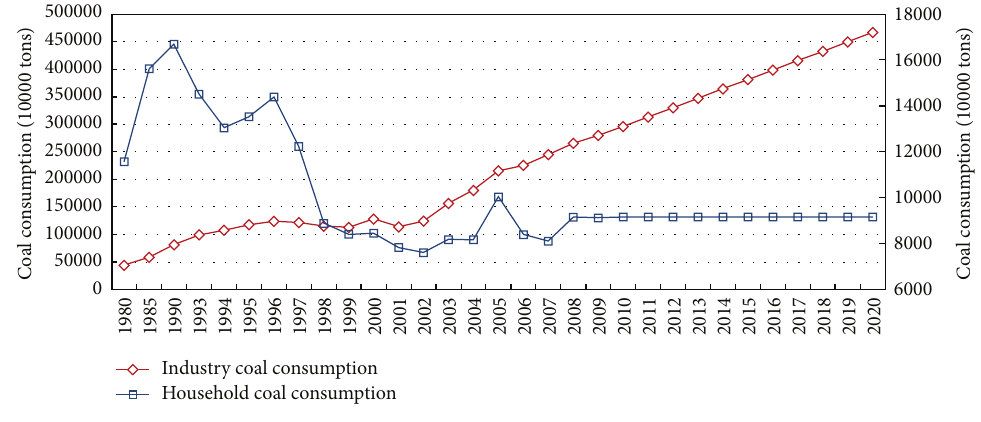
Figure 4: Changes of industry and household coal